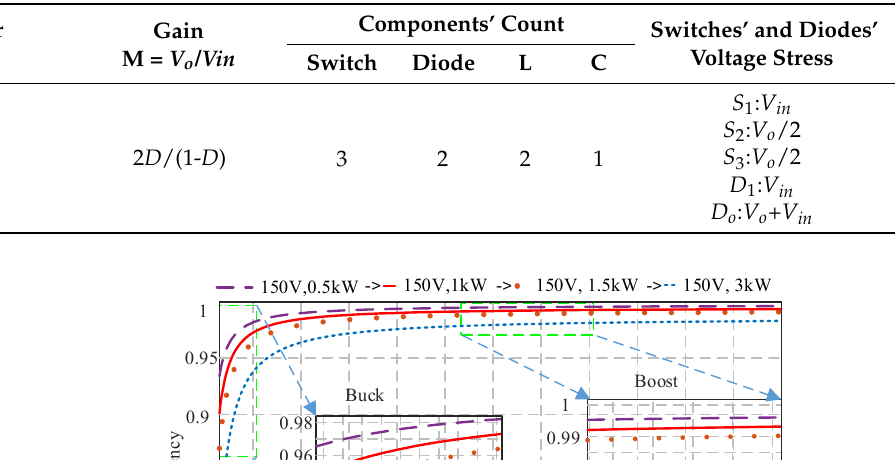
- > ( c ) Figure 9. Different cases of study for the proposed converter: ( a ) Voltage gain at different duty cycle and different loading. ( b ) Voltage gain with fixed loading and different input voltages. ( c ) Converter efficiency at different input voltages. However, in both case studies, the differences in the voltage gain do not have a very